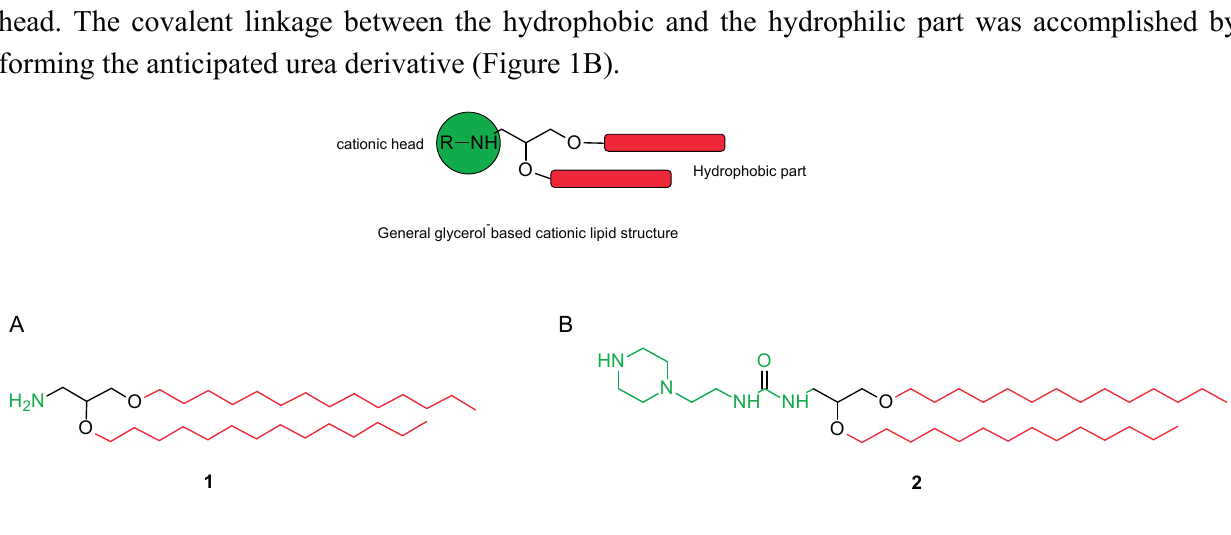
Figure 1. Di( O -alkyl)glycerol-based cationic lipids general structure. ( A ) Compound ( 1 ) was successfully evaluated as a transfecting agent; ( B ) The title compound ( 2 ) was designed as a second-generation molecule from our “lead compound 1